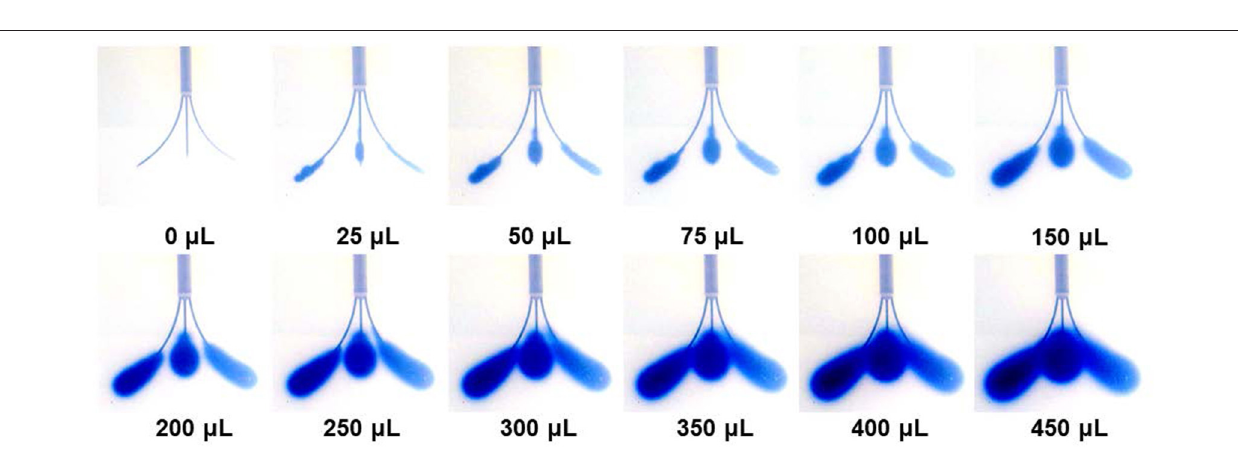
FIGURE 5 | Snapshots of the volume distribution V D during CED injections at 3 µ L/min from each microcannula (total flow rate = 9 µ